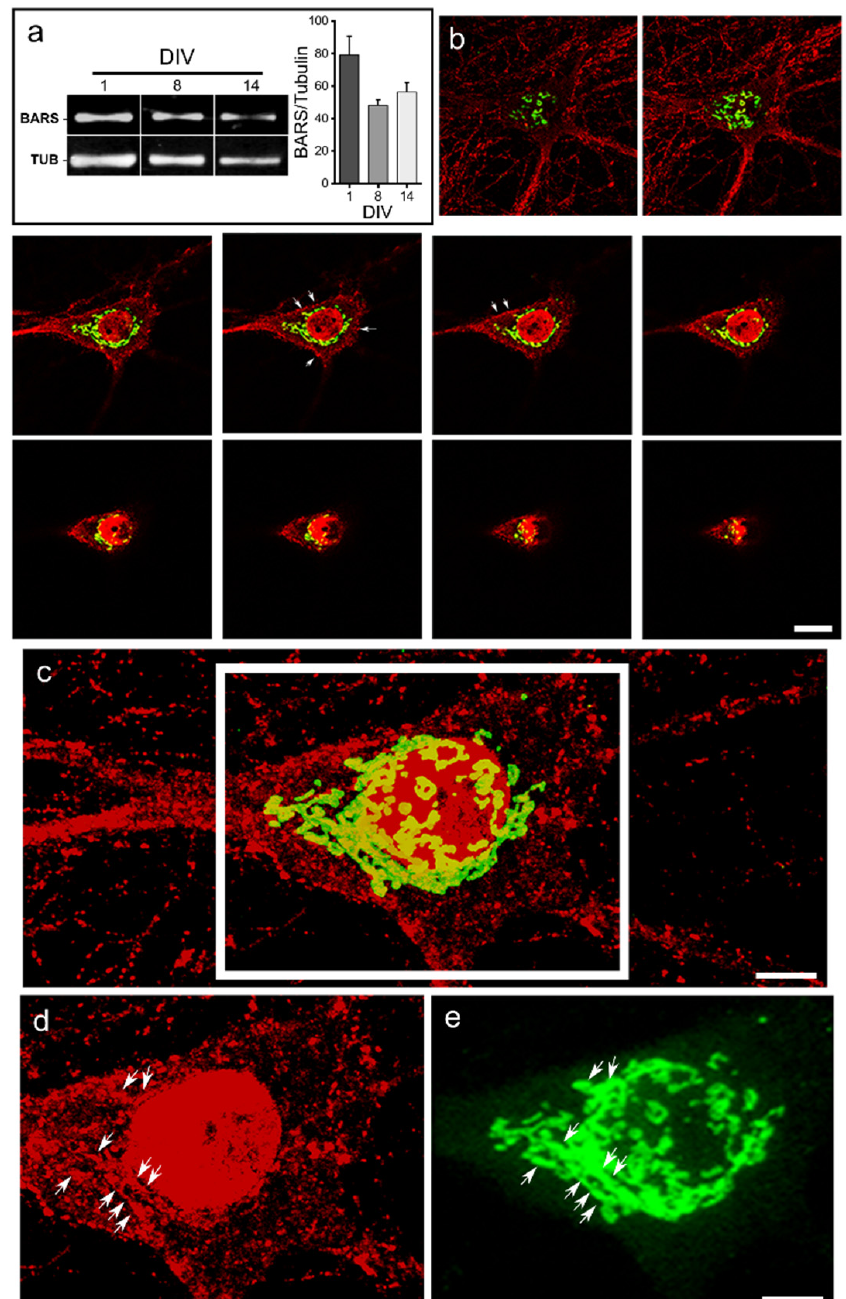
Figure 1. Expression and distribution of BARS in cultured neurons. ( a ) Western blots (left panel) and quantification (right panel) showing the presence of BARS in cell extracts obtained from cultured hippocampal neurons after development for 1, 8, and 14 DIV (days in vitro). TUB: α -tubulin. Graphs represent mean ± S.E.M. of BARS densitometry data normalized to α -tubulin. One-way ANOVA test. Three independent cultures per group were analyzed. ( b ) A z -series of confocal images from a 14 DIV cultured hippocampal neuron showing the distribution of BARS (red) and GM130 (green). Note that BARS immunofluorescence localizes to the cell nucleus, the cell soma, and neurites (punctate labeling); labeling is also observed in close proximity to the plasma membrane (arrows) and the Golgi region. Scale bar: 5 µ m. ( c ) A maximal projection image collected from the images shown in ( b ). ( d , e ) Single channel of the insert in ( c ) showing the distribution of endogenous BARS ( d , red) and the Golgi marker GM130 ( e , green). Note that BARS immunolabeling partially colocalizes with GM130 + profiles (arrows). Scale bar: 2.5 µ